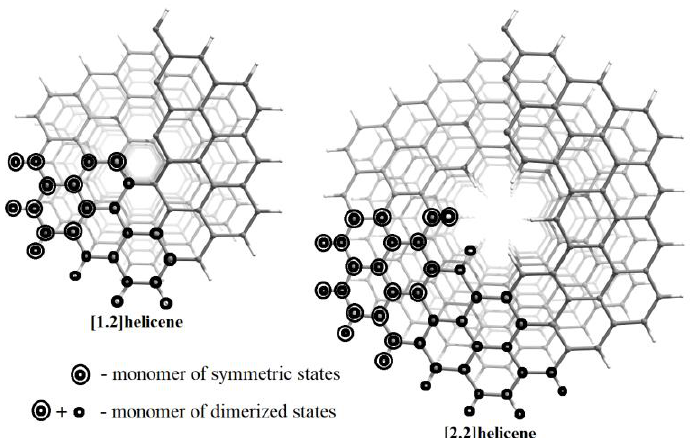
Figure 1. Top view of the atomic structure of NHs under consideration. The symmetry groups of the presented structures are L 6 1 or L 3 1 for symmetric or dimerized states, respectively. White and gray colors represent hydrogen and carbon atoms, respectively.